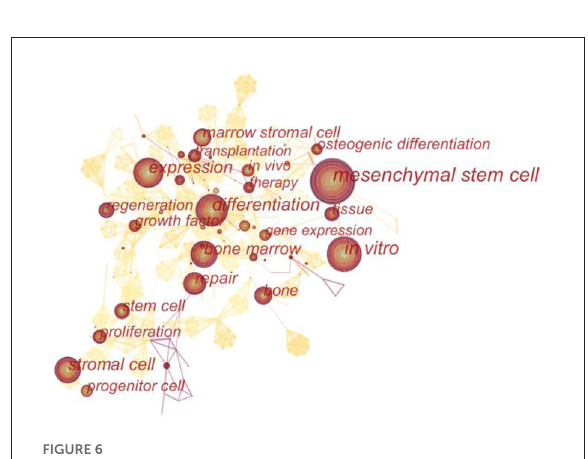
FIGURE6 Co-occurrence map of keywords in MSCs in orthopedics from 2002–2021.